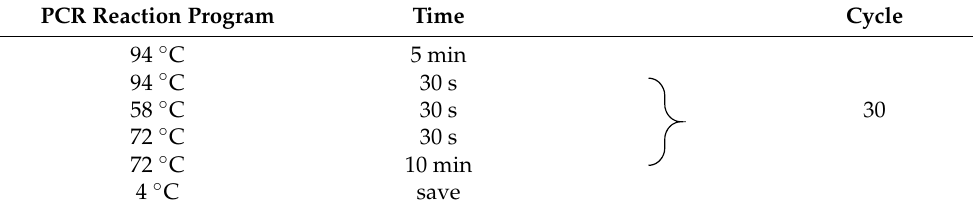
Table 2. PCR reaction program.